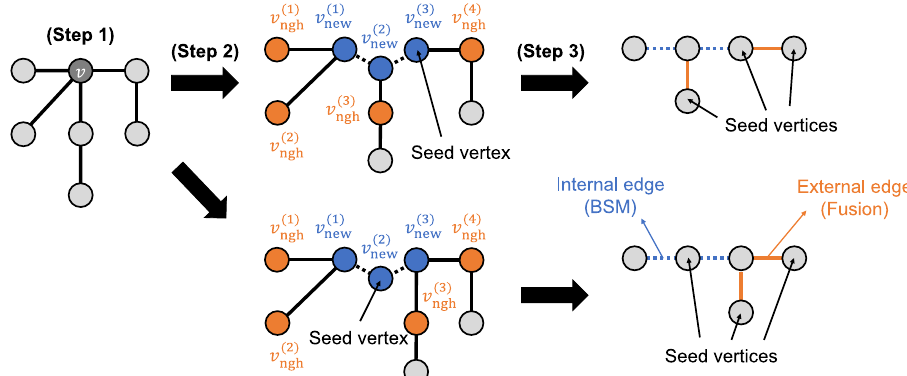
Fig. 10 Construction of merging graphs from a physical-level graph. v is the only vertex with a degree larger than two in the original graph. The upper and lower processes differ in the selection of the seed vertex for the decomposition of v